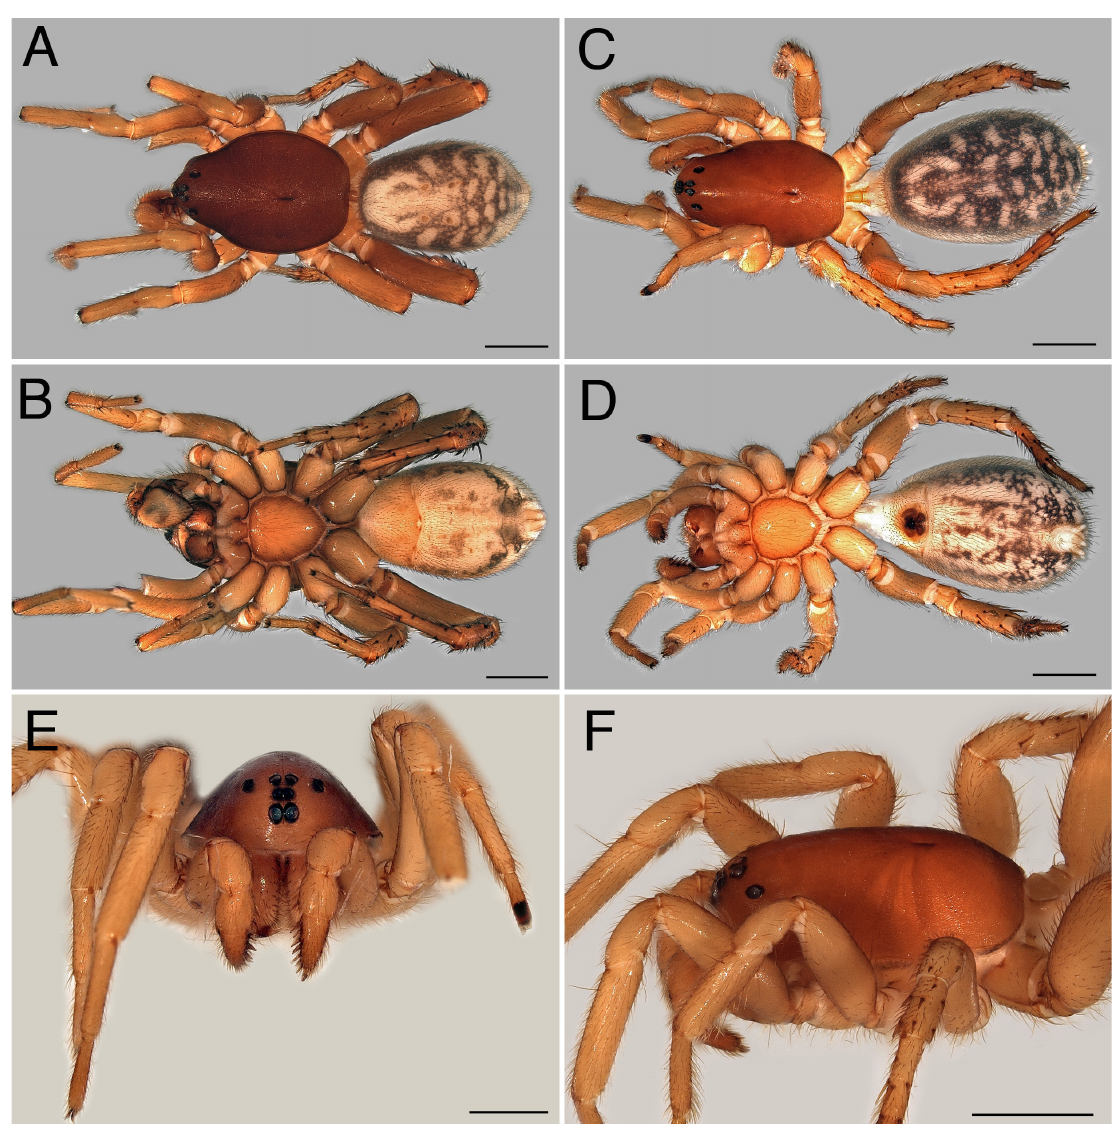
Fig. 6. Ballomma haddadi gen. et sp. nov. A–B . Holotype, ♂. C–F . ♀ (MRAC 132641). A . Habitus, dorsal view. B . As preceding, ventral view. C . Habitus, dorsal view. D . As preceding, ventral view. E . Prosoma, frontal view. F . Prosoma, dorsolateral view. Scale bars: 1